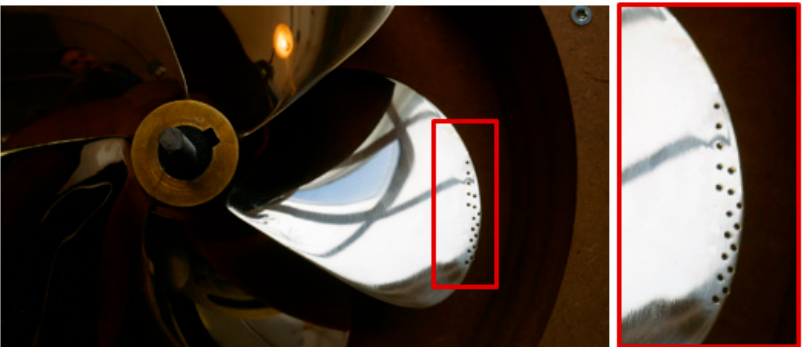
Figure 8. Princess Royal “Modified Propeller-2”.